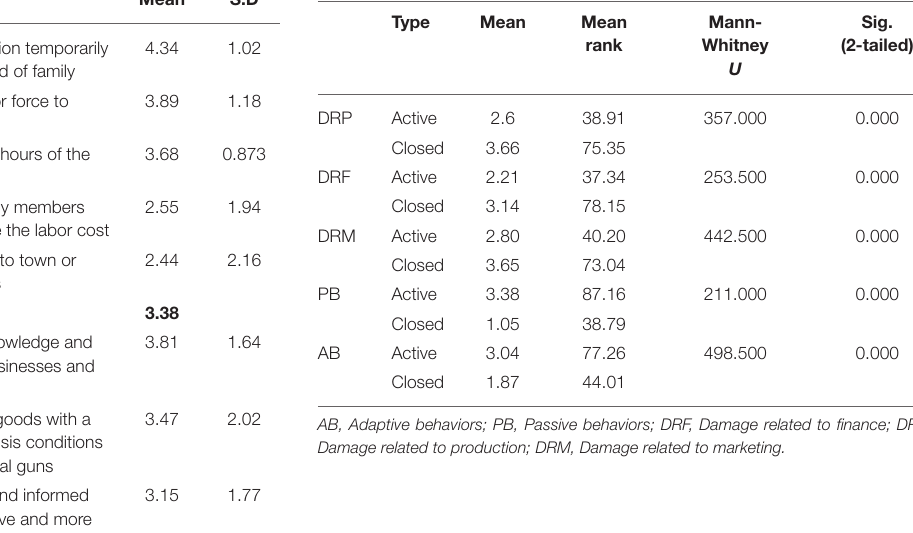
TABLE 8 | Comparison of active and closed firms in sustained damages and token responses.